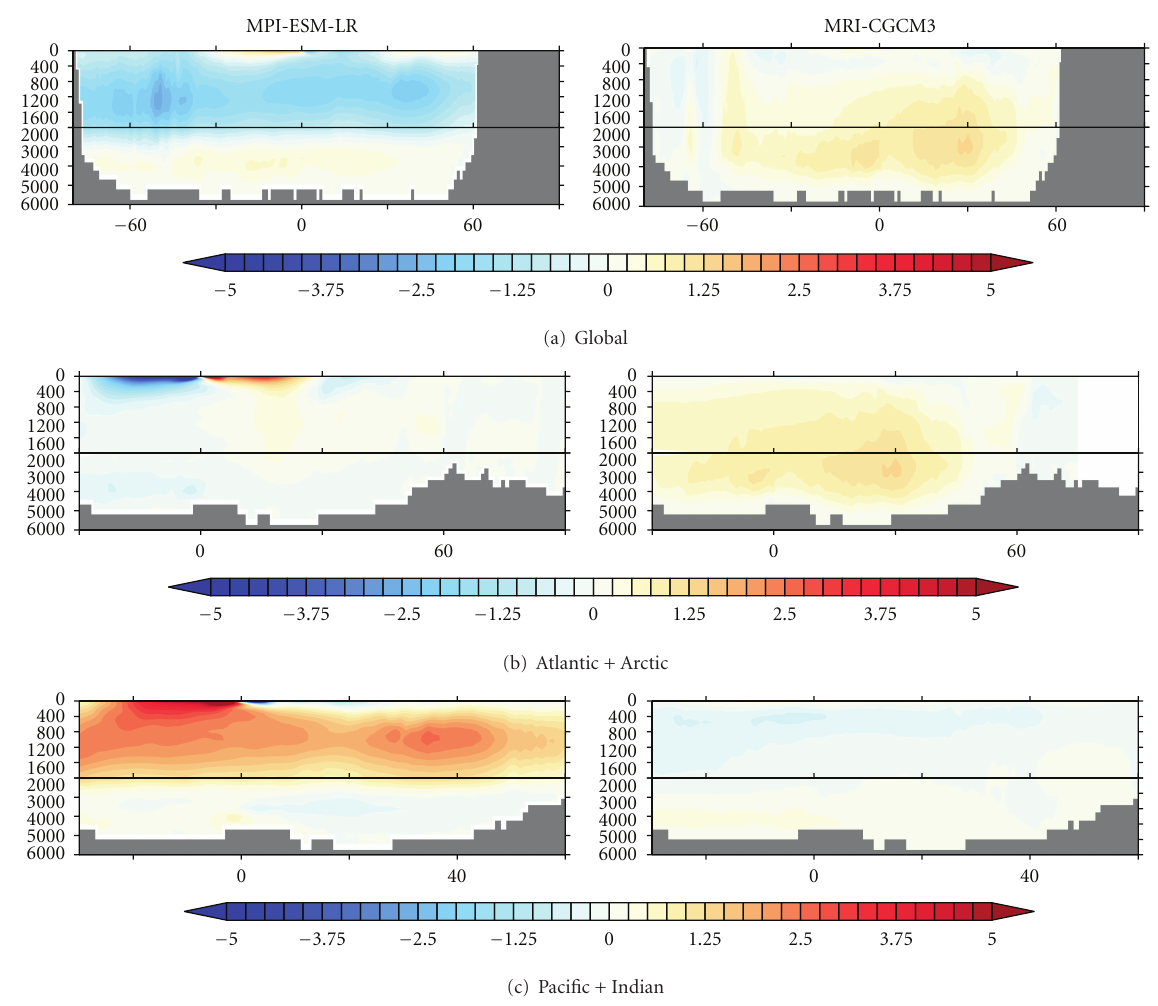
Figure 6: Ocean meridional overturning mass-stream function anomaly of global mean (a) and ocean basins (b through c). The abscissa is latitude in degrees and the ordinate is water depth in meters. Notice that depth is unevenly distributed. The overturning mass-stream function anomaly is in × 10 10 kgs − 1 . MOC weakens in the upper ocean whereas the AABW is enhanced. It is of note that MOC change in the Pacific and Indian Oceans are di ff erent in MPI and